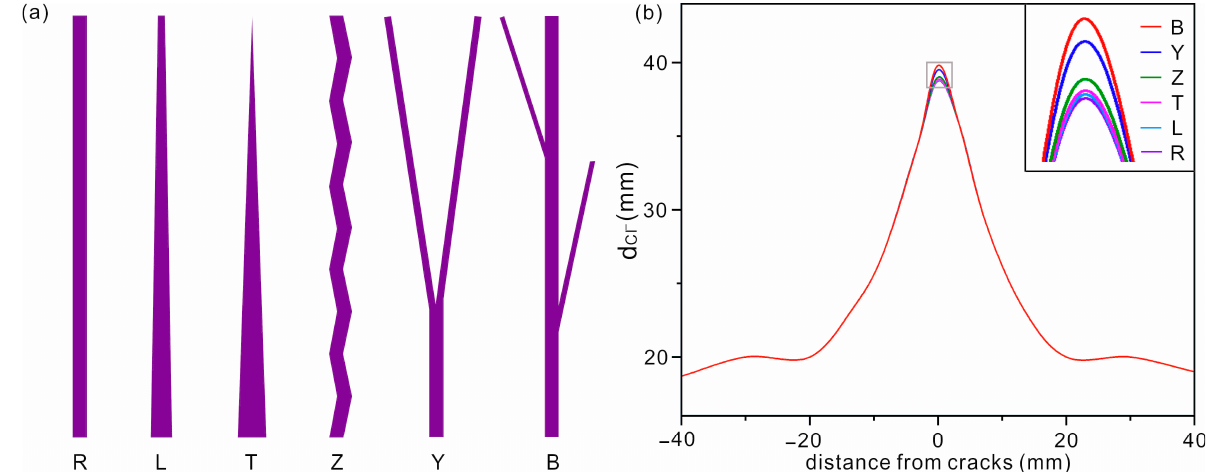
Figure 6. ( a ) Schematic diagram of AC with di ff erent shapes, including rectangular (R), ladder- shaped (L), triangular (T), zigzag (Z), Y-shaped (Y) and branched (B). The width and length of the rectangular ACs are 102.9 µm and 36.6 mm, respectively. The area of these six ACs is set to a constant 3.77 mm 2 . ( b ) Di ff usion depth of chloride ions in concrete with di ff erent shapes of ACs. The enlarged 3.77 mm 2 . ( b ) Diffusion depth of chloride ions in concrete with different shapes of ACs. The enlarged zone around the ACs is shown as an inset. zone around the ACs is shown as an